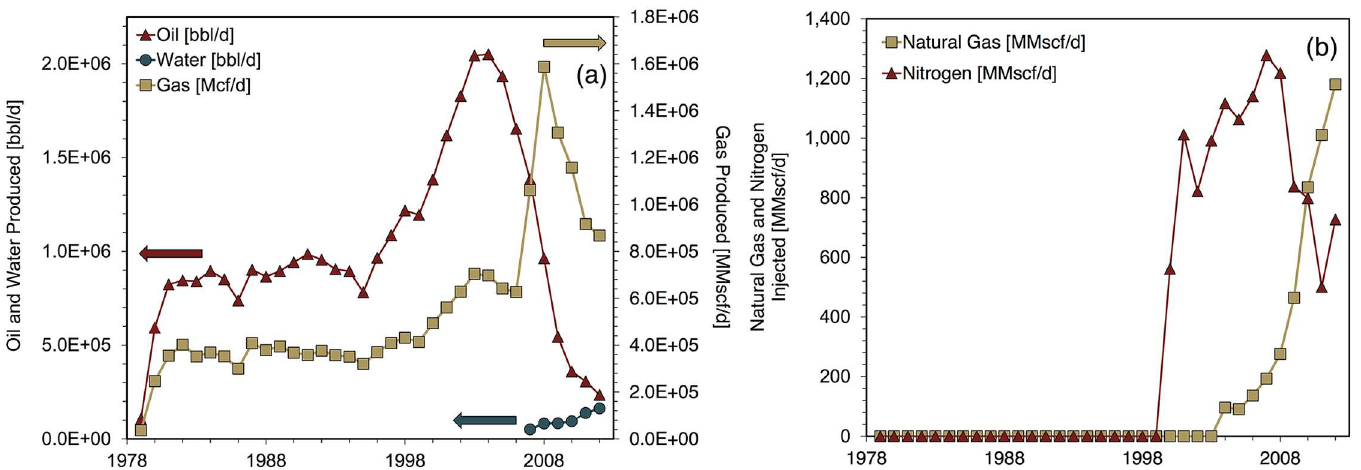
Fig 2. Cantarell input data for fluid production and injection. (a) Fluid production,(b) fluid injection. Source: